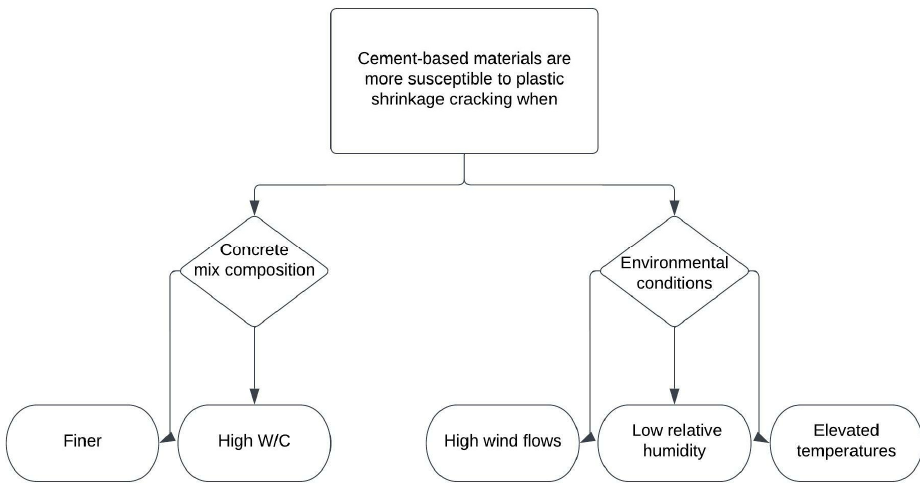
Figure 1. Factors affecting plastic shrinkage cracking [22].